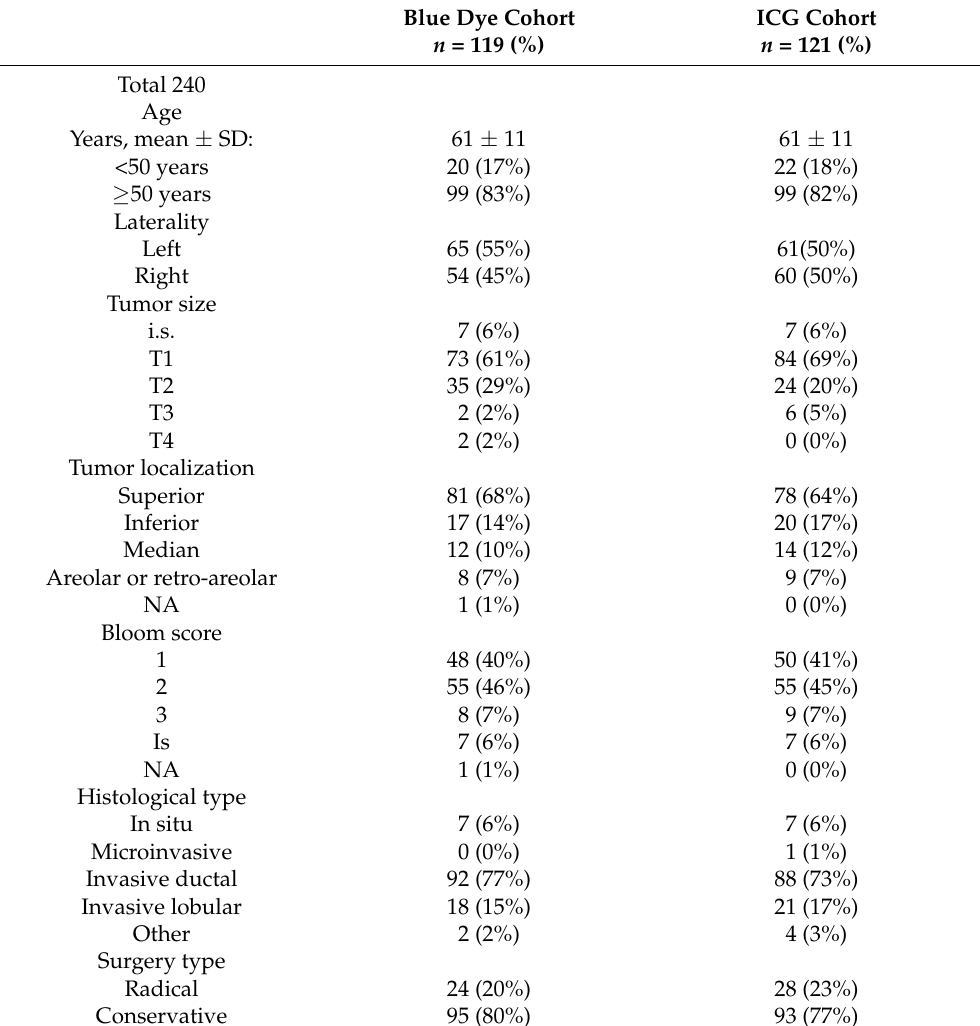
Table 1. Characteristics of patients and tumors.